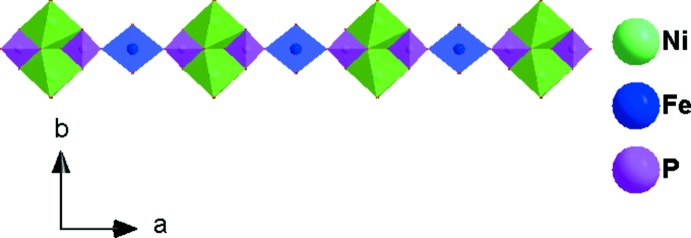
A chain formed by sharing edges and corners of [Ni22O10] dimers, [P2O4] tetra­hedra and [FeO6] octa­hedra along the [100] direction